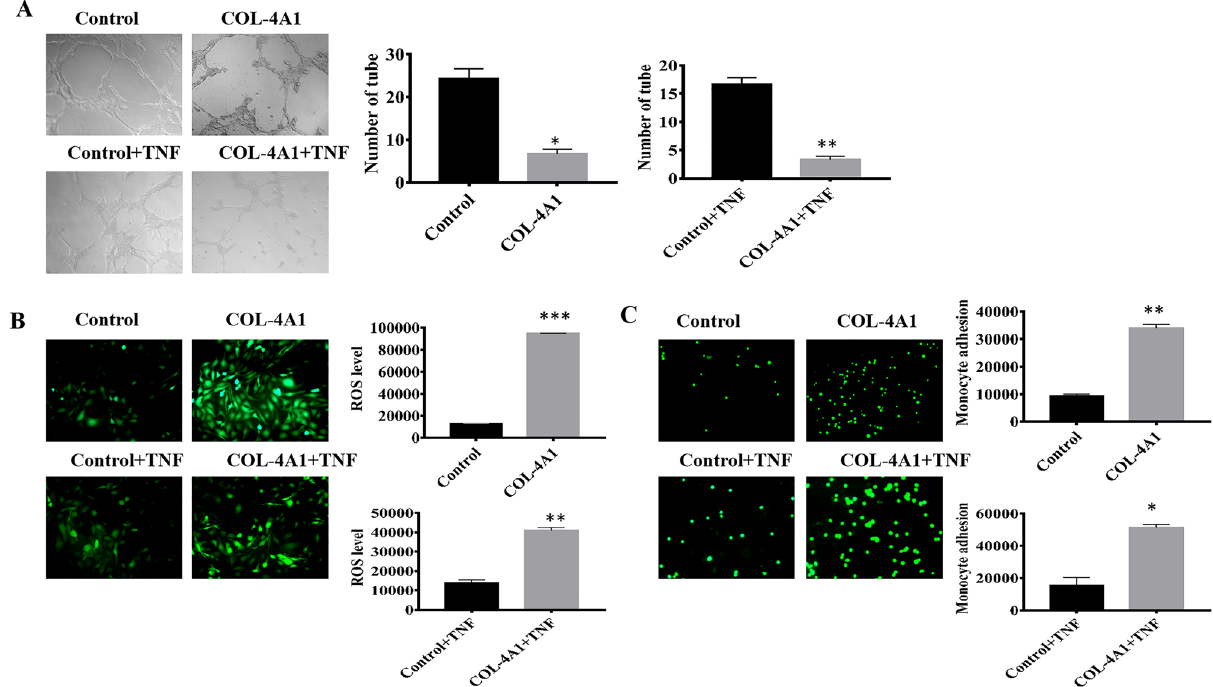
Figure 3. Effects of COL-4A1 on tube formation, ROS levels, and adhesive ability. ( A ) Qualitative and quantitative analyses of tube formation by HUVECs. Tube formation was eliminated in the COL-4A1-treated cells (with or without TNF-α). ( B ) COl-4A1 obviously increased the level of ROS in each group. (C) COl-4A1 increased the adhesive ability of each group. All images were captured at ×100 magnification. (* P < 0.05, ** P < 0.01, *** P <